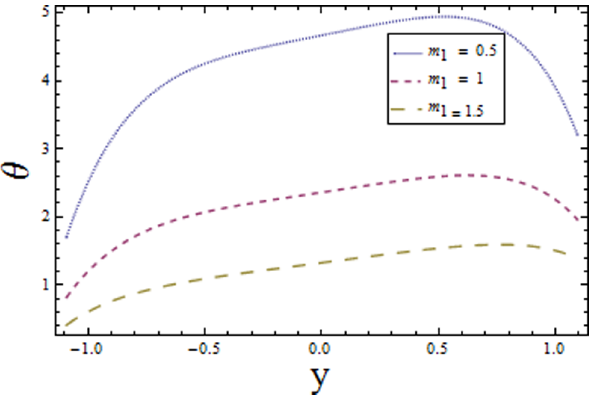
Figure 6. Plot of temperature h for Hartman number m 1 with E ~ 0 : 1 , t ~ 0 : 01 , x ~ 0 : 2 , ª 1 ~ 4 , ª 2 ~ 6 , E 1 ~ 0 : 4 , E 2 ~ 0 : 2 , E 3 ~ 0 : 3 , Br ~ 1 , n ~ 0 : 4 , We ~ 0 : 4 and m ~ 0 : 04 :